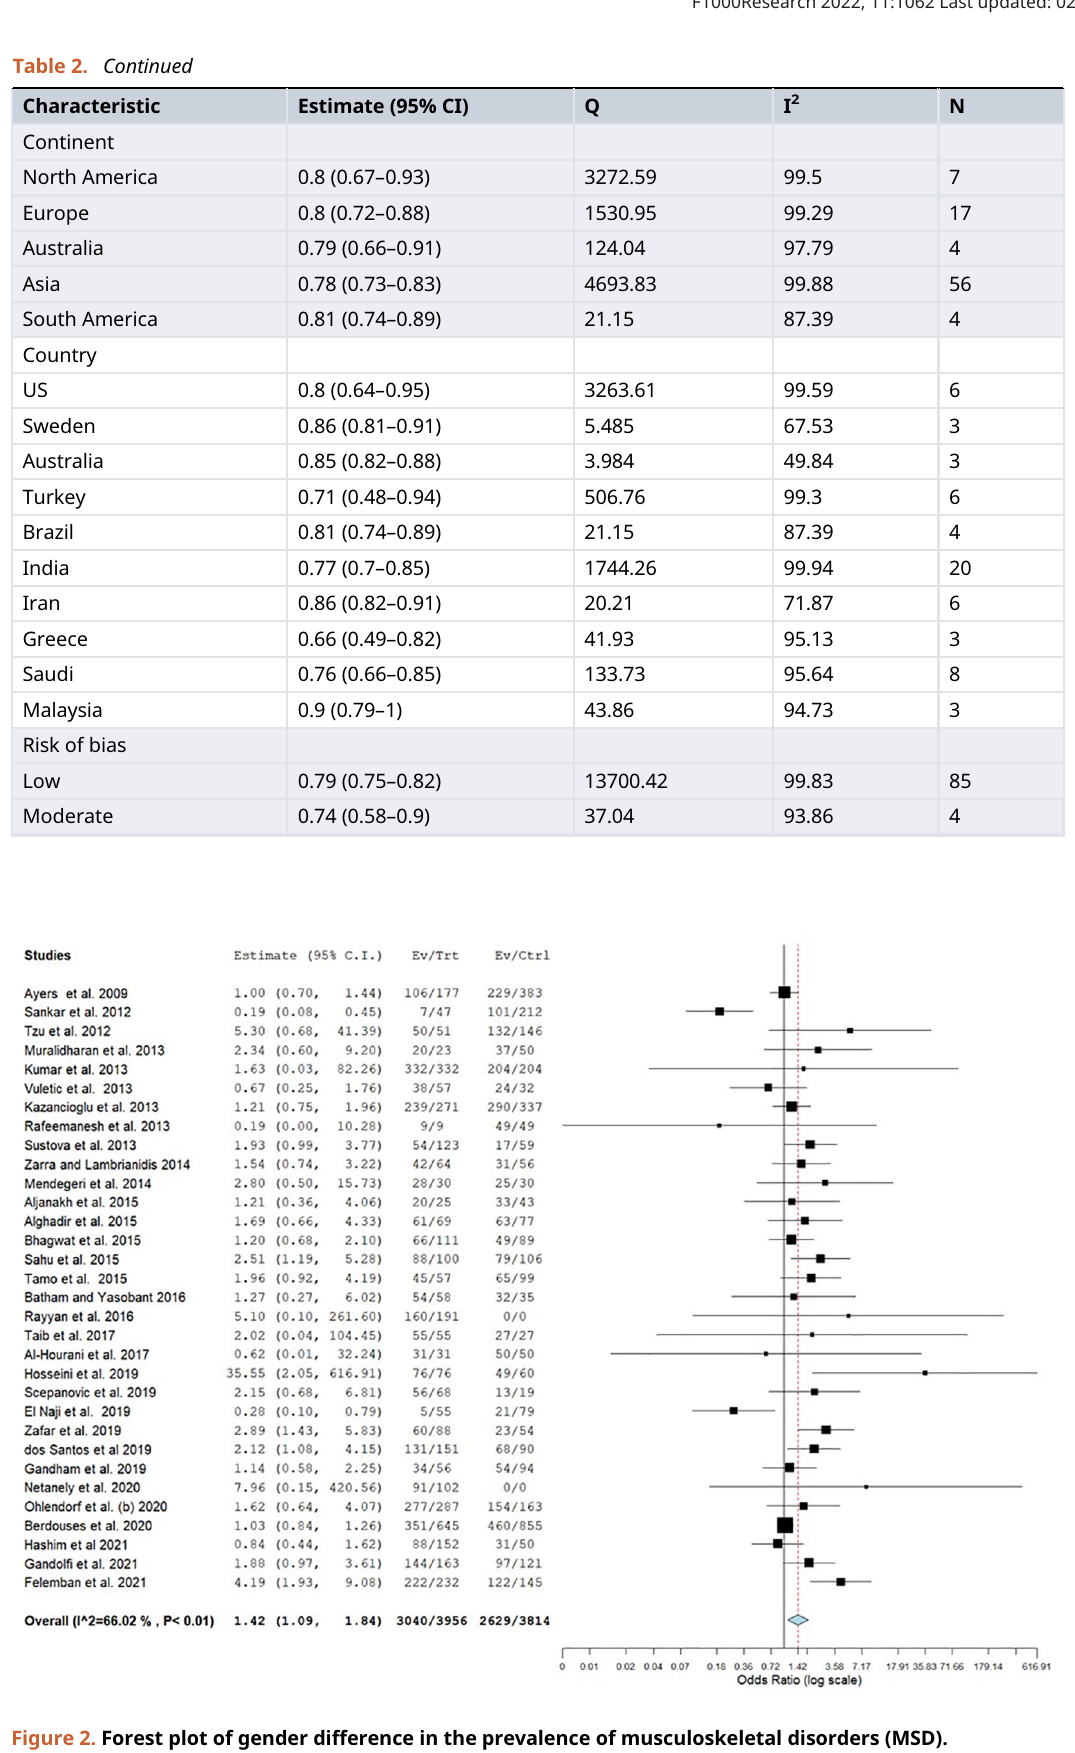
Figure 2. Forest plot of gender difference in the prevalence of musculoskeletal disorders